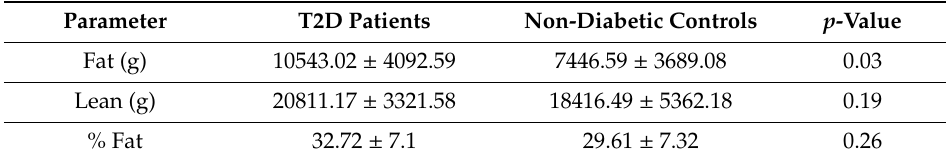
Table 5. Comparison of Trunk composition by DEXA.